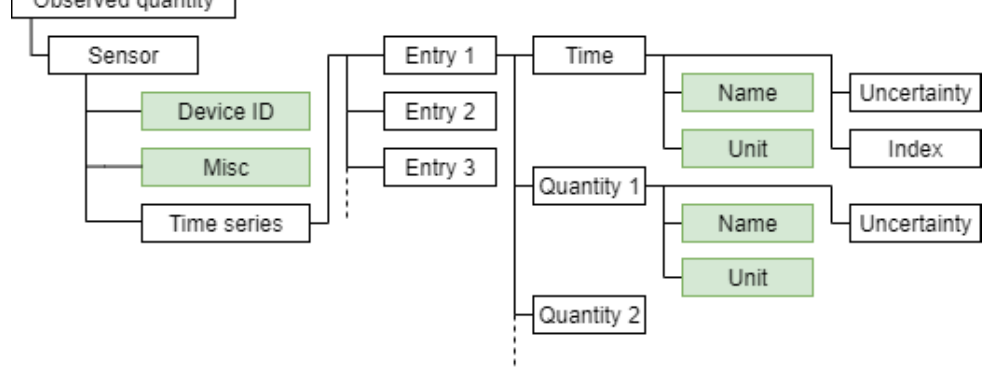
Figure 8. Abstract representation of a time series corresponding to data from a given sensor. The metadata necessary to interpret the actual measured quantities and time instances is contained in the scheme. The fields with green shading correspond to the metadata